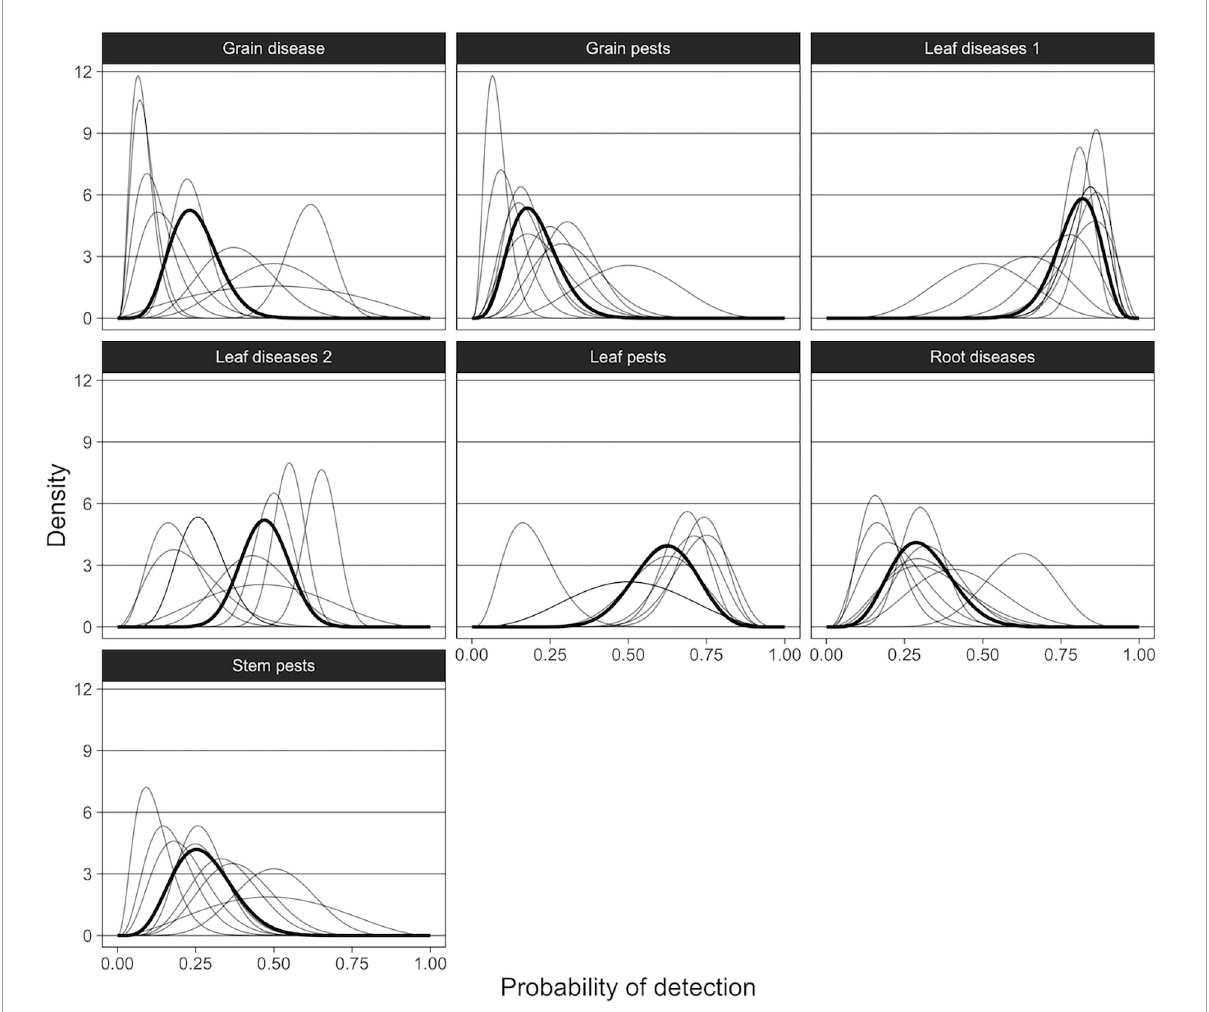
FIGURE6 Probability density functions of the aggregated Beta distributions, showing the probability of detection during visual inspection for each pest/disease grouping as estimated by the experts. Thin lines represent individual experts’ estimates and bold lines represent aggregated densities by minimizing Kullback–Leibler